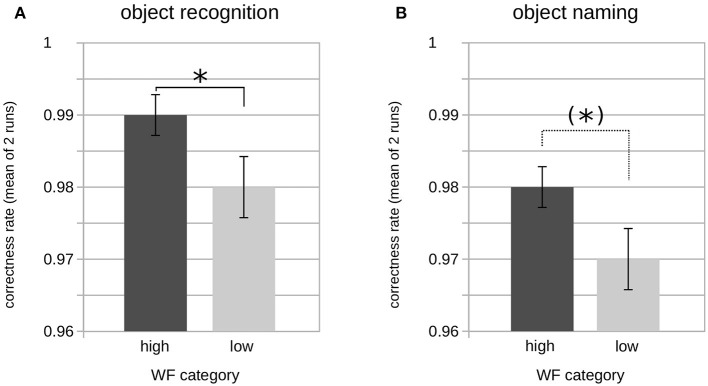
Rates of correct object recognition and naming by word frequency category. Bar plot showing the average correct object recognition (A) and object naming (B) rates of both runs (pooled) by word frequency (WF). Significant differences according to groupwise post-hoc comparison of means are indicated by asterisks [(*)p < 0.1; *p < 0.05]. Please note the limited ranges of the y-axis, for better readability.